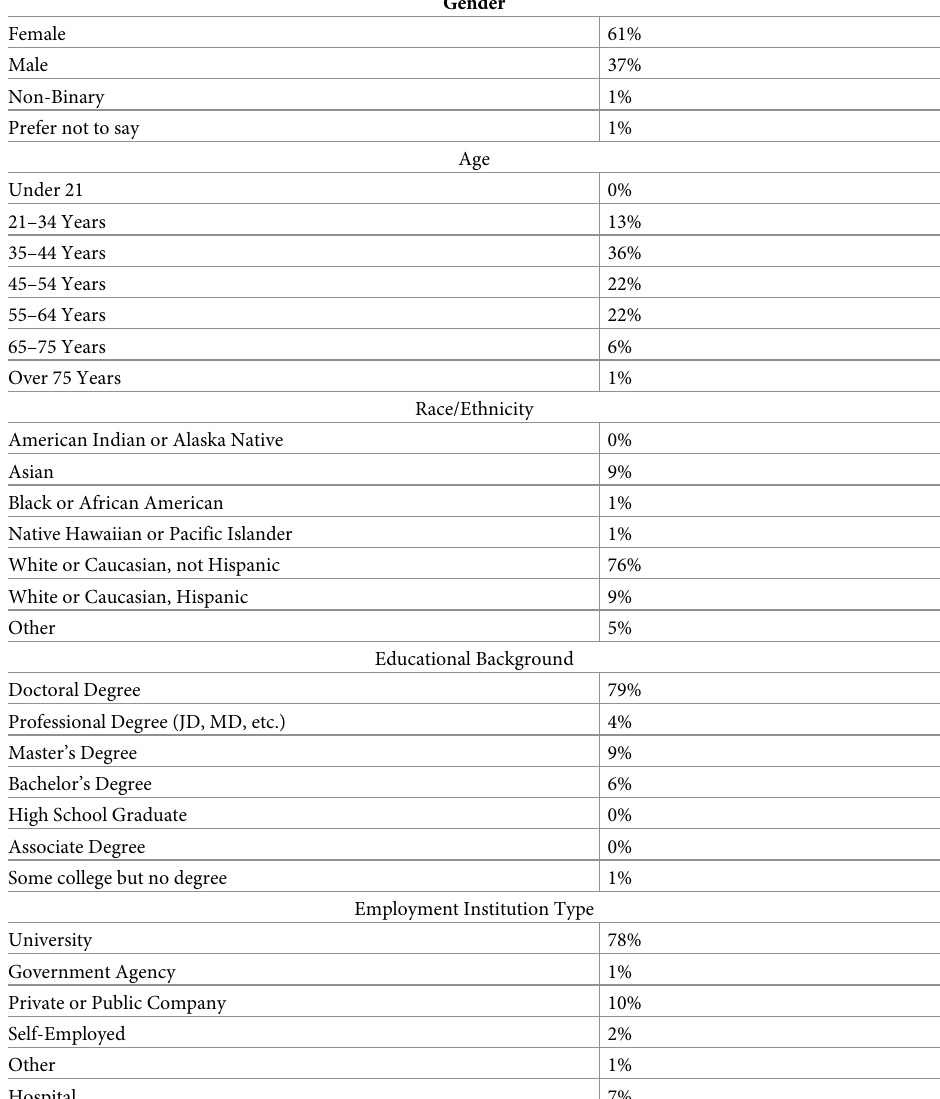
Table 1. Respondent demographic